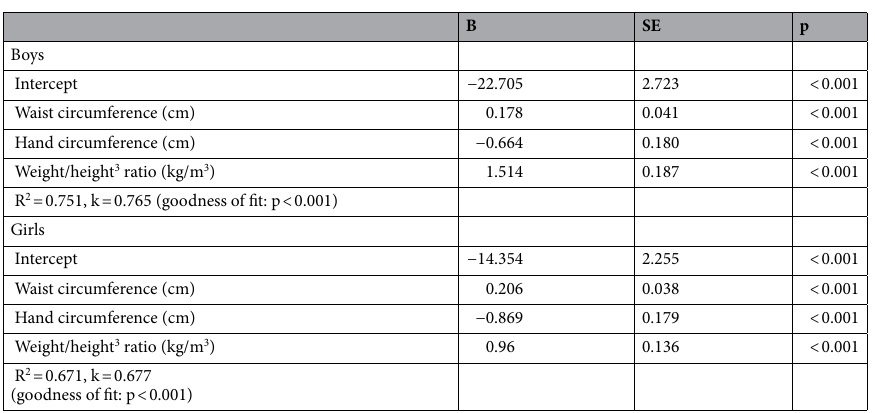
Table 4. Descriptive statistics of multinomial logistic model to identify strongest predictor of nutritional status in children aged between 7–18 years. B: estimated regression coefficient, SE: standard error of B, p: significance level of the regression; goodness of fit test: R 2 : the proportion of variance in nutritional status explained by the predictors, k: kappa coefficient, p: significance level of goodness of fit